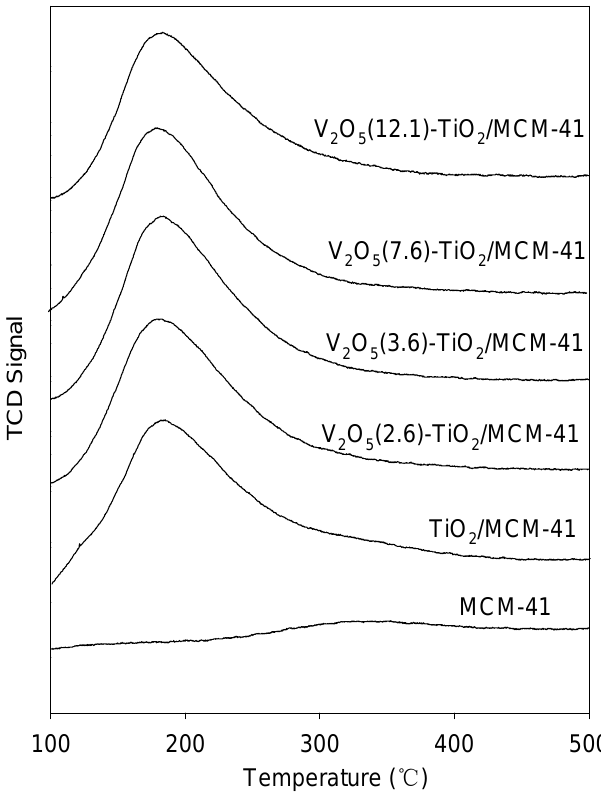
Figure 4. Temperature-programmed desorption of ammonia over various